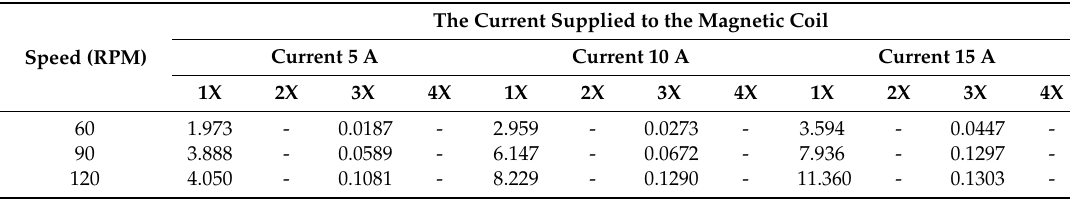
Table 4. The electromotive force obtained from change in speed and dipole magnet current.